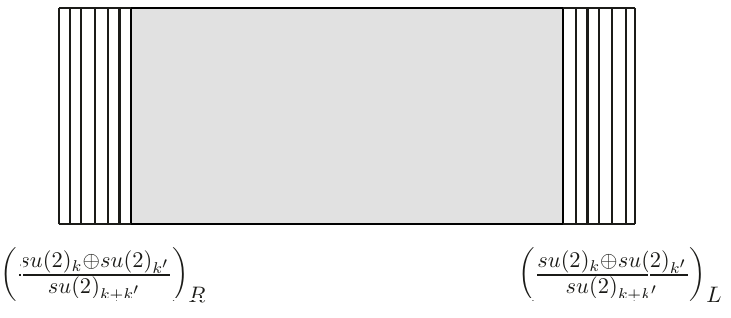
Figure 3 . The resulting topological phase from coupling quantum wires. The shaded region corresponds to the gapped bulk due to the interactions while the opposite ends correspond to the gapless edge states of different